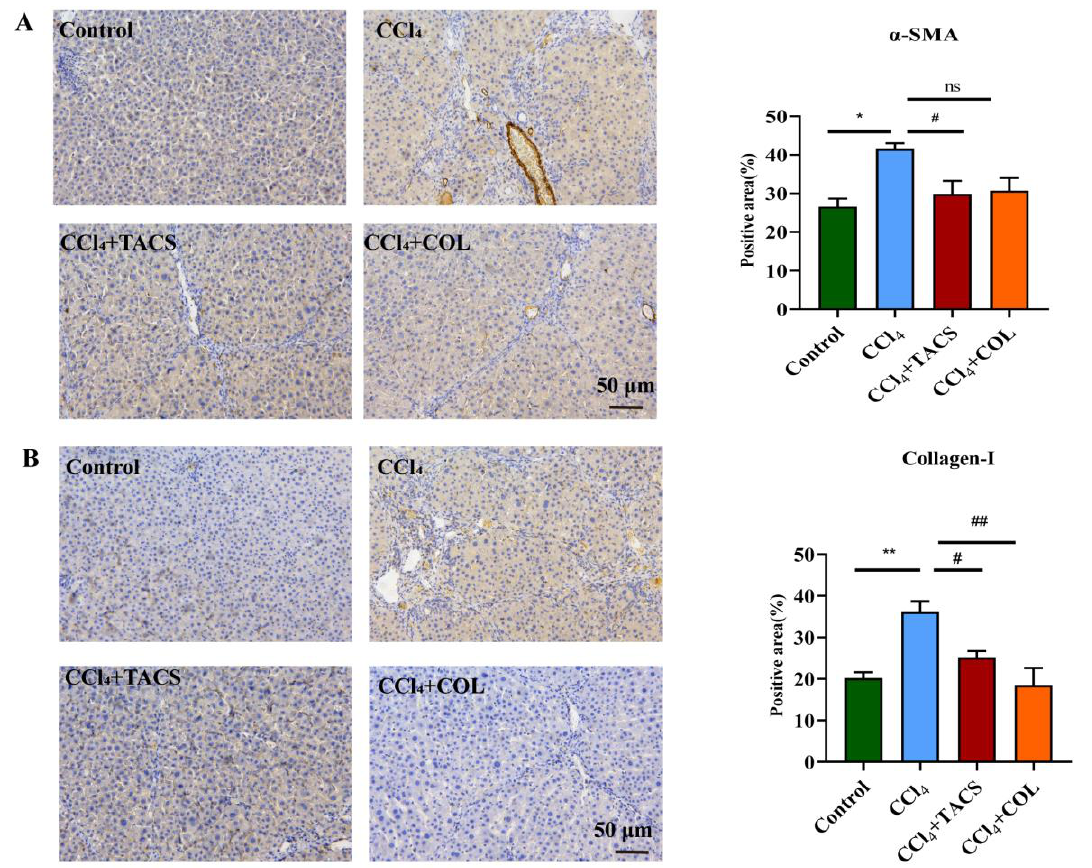
Figure 2. TACS inhibited α -SMA and collagen-I expression in CCl 4 -induced rats. ( A ) α -SMA immunohistochemistry representative photos and the positive area of α -SMA expression ( n = 3). ( B ) Collagen- Ι immunohistochemistry representative images and the positive area of collagen - Ι expression ( n = 3). Data were expressed as the mean ± SEM. * p < 0.05, ** p < 0.01 vs. control group; # p < 0.05, ## p < 0.01 vs. CCl 4 -treated group, ns represents no significance.